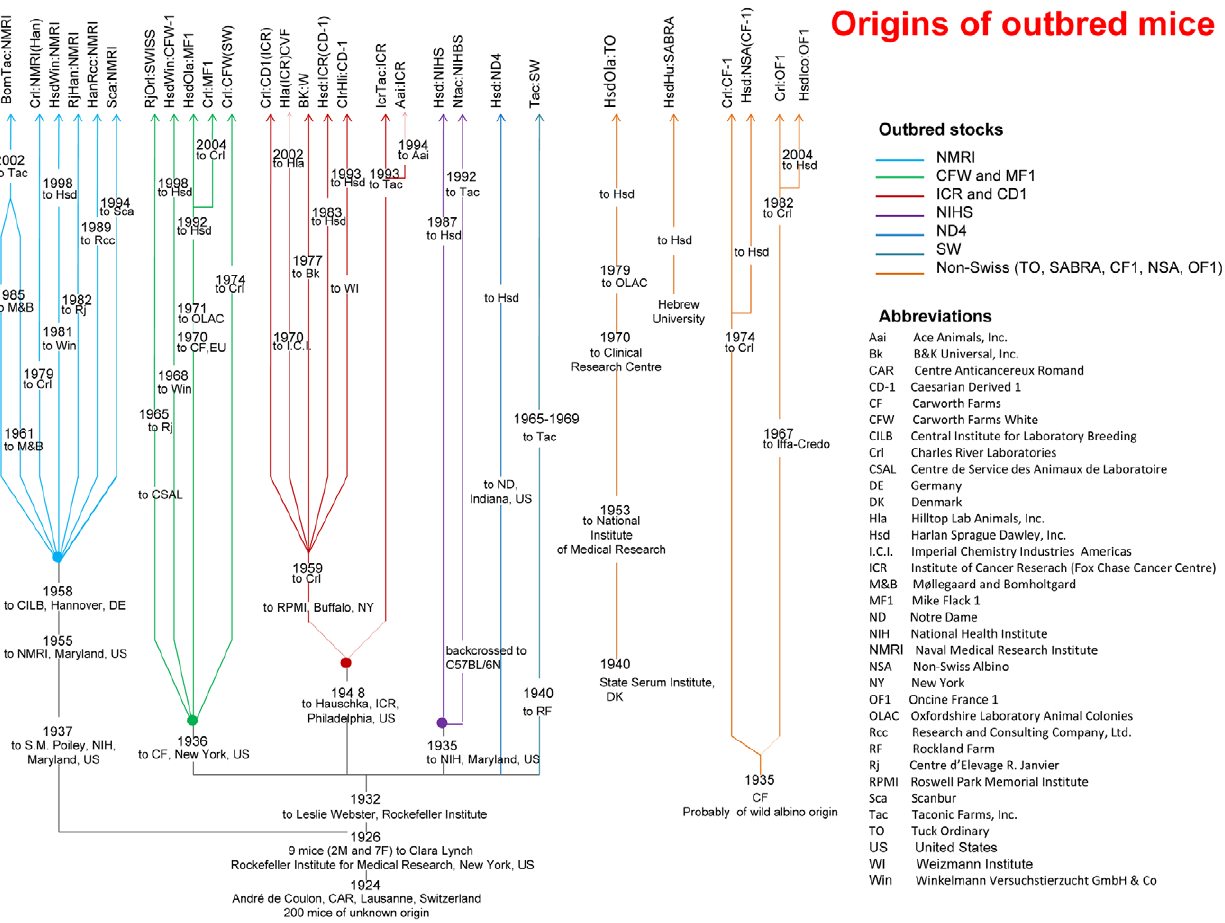
Figure 1. Ancestry of commercially available outbred stocks. Most outbreds have a common origin: they descend from a single Swiss colony of 200 mice from which 2 males and 7 females were imported to the Rockefeller Institute for Medical Research in New York [5]. Outbred Swiss stocks currently available include NMRI, CFW, MF1, CD1, ICR, NIHS, ND4 and SW. Not all outbreds descend from Lausanne in Switzerland. Non-Swiss strains include CF-1, NSA, OF1, SABRA and TO. Details on the origin of colonies are provided in Text